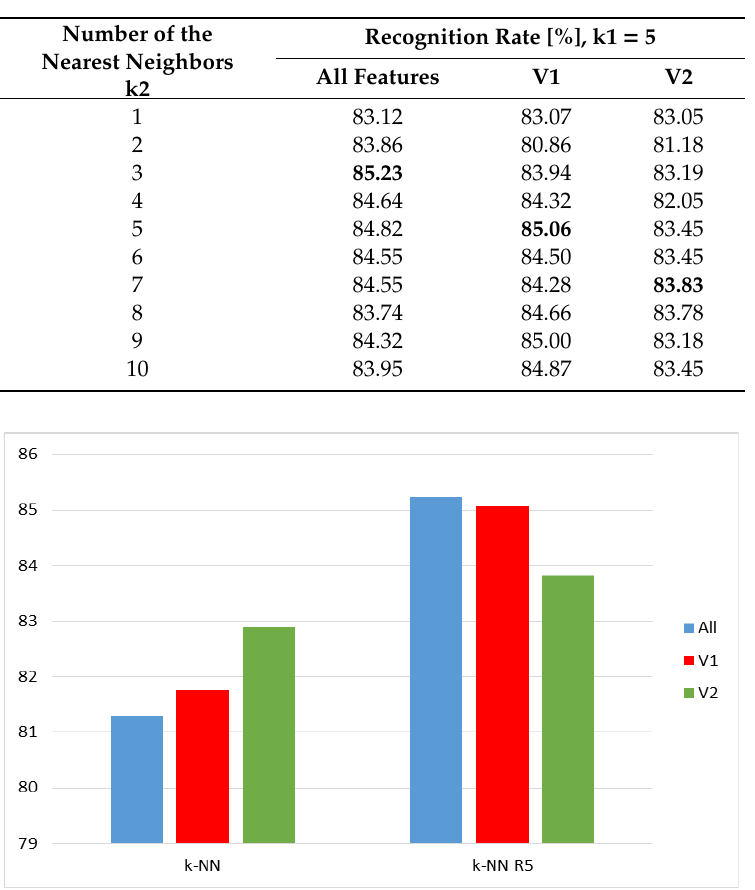
Figure 10. Recognition rates for the MSR Action 3D set: original k-NN (left) and k-NN using representatives.